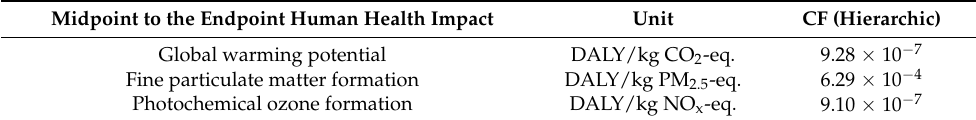
Table 3. Midpoint to endpoint human health CFs.